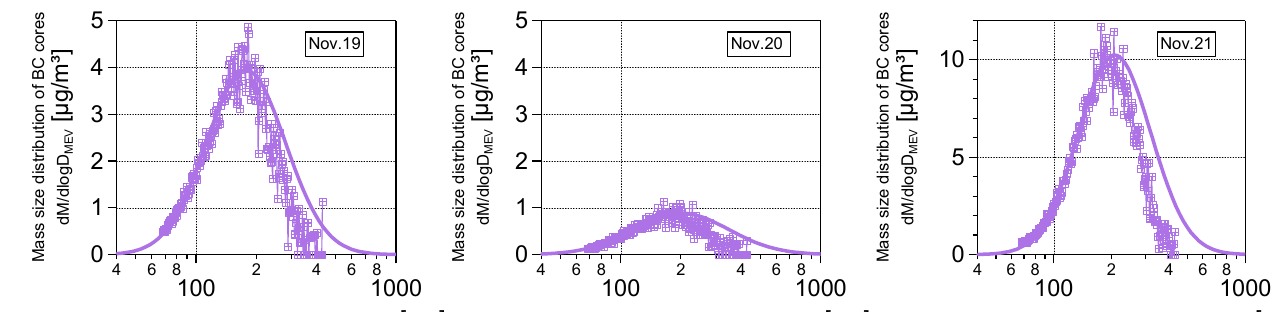
Figure 6. Size distribution of BC in snow.